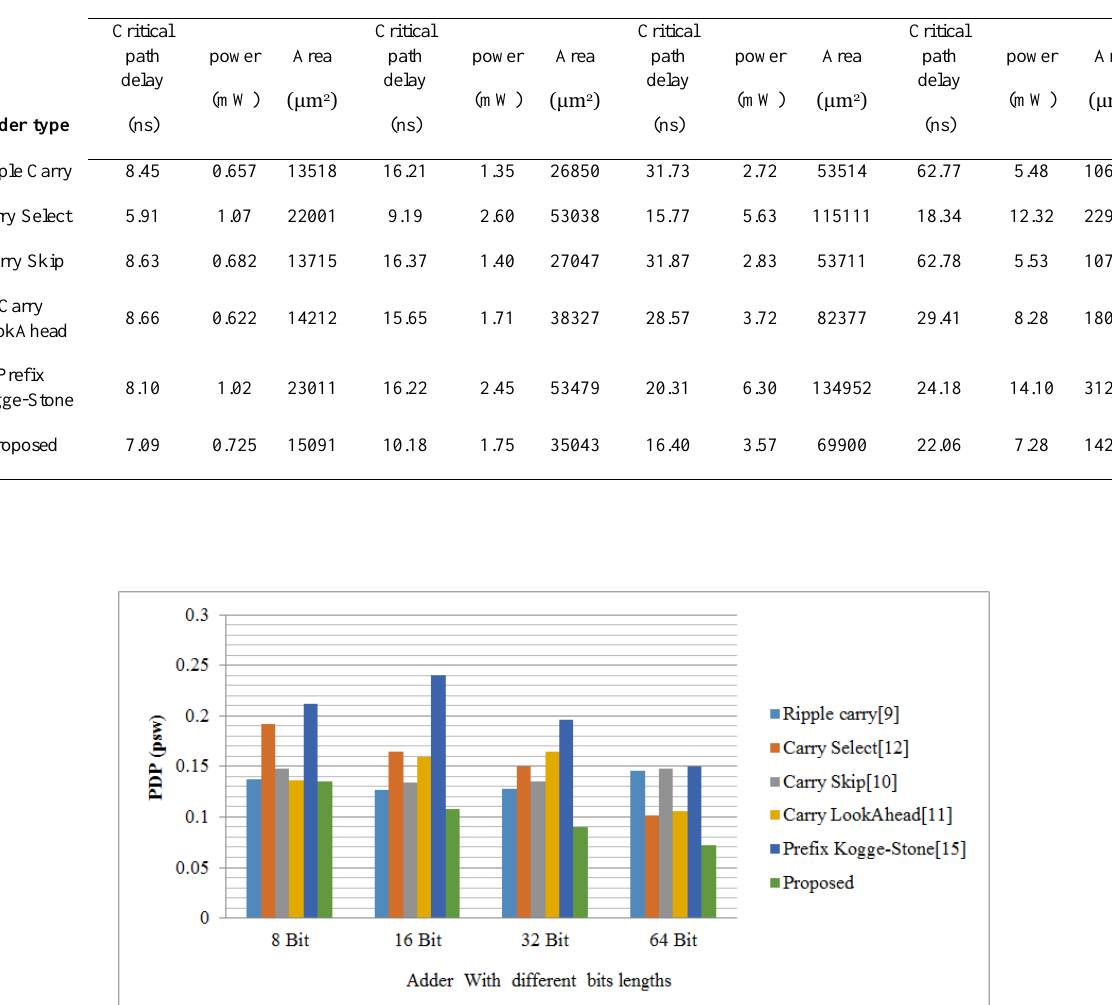
Figure 14. Comparing the PDP of the proposed adder and other